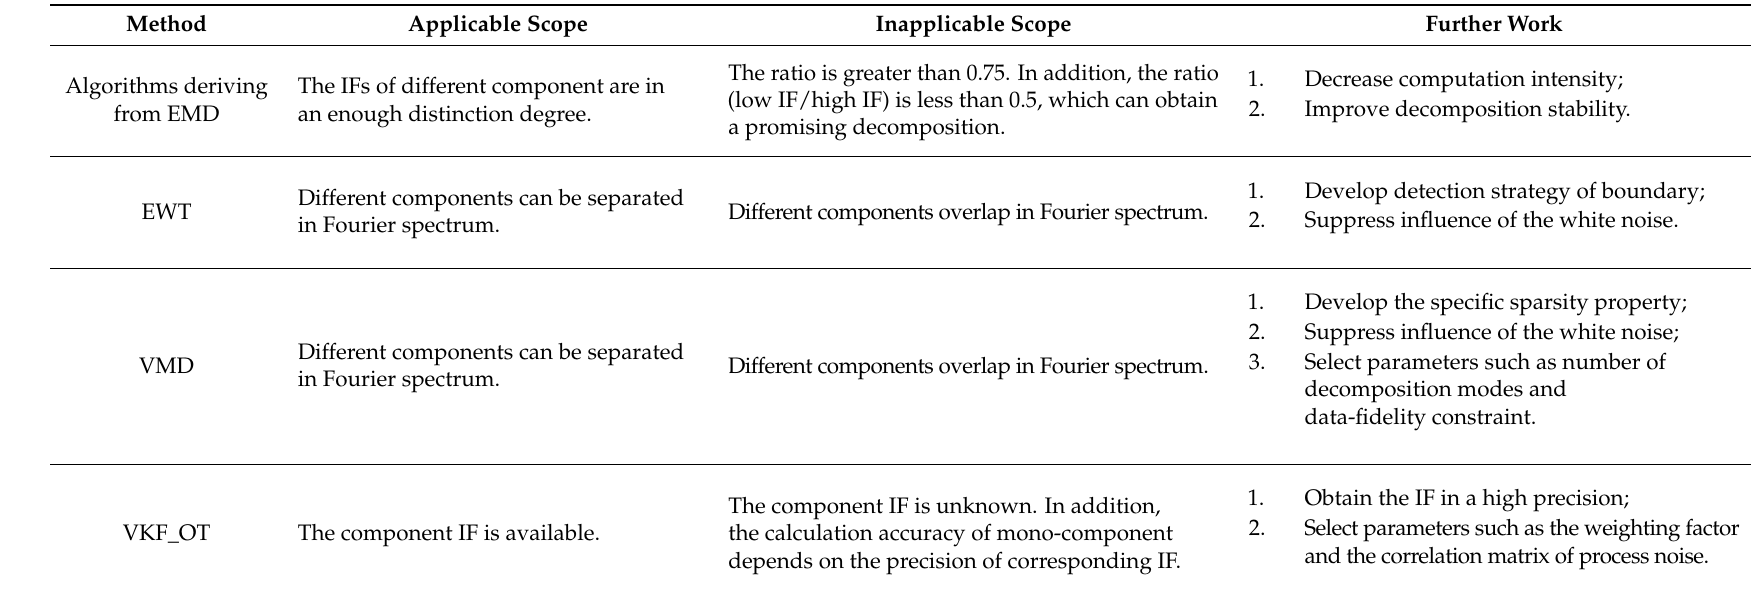
Table 3. Comparison of various time–frequency analysis methods for the precise operation. It should be noticed that algorithms deriving from EMD that are referred in this paper include EEMD, CEEMD, CEEMDAN, and improved CEEMDAN, and the number of sifting iterations is set as 2000, and the stopping criterion threshold is set as 0.05. The conclusion about algorithms deriving from EMD is obtained under these conditions of parameter